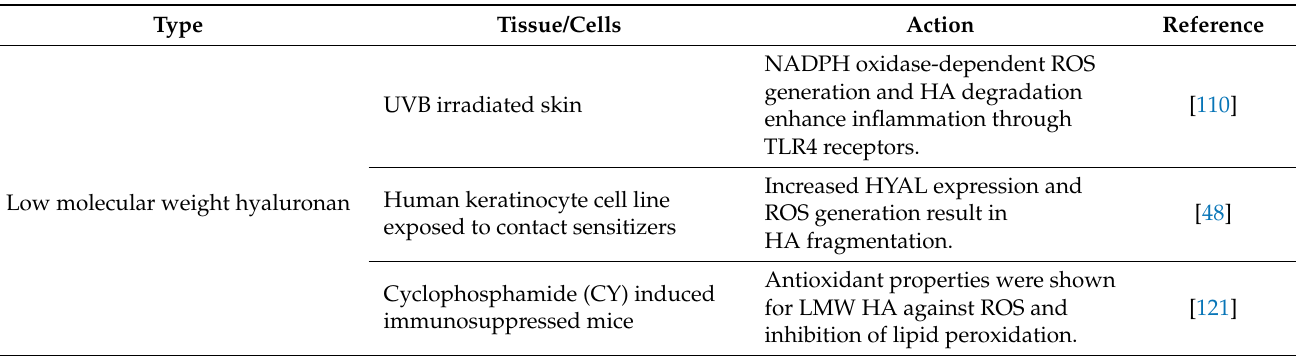
Table 2. LMW HA/HMW HA and ROS in